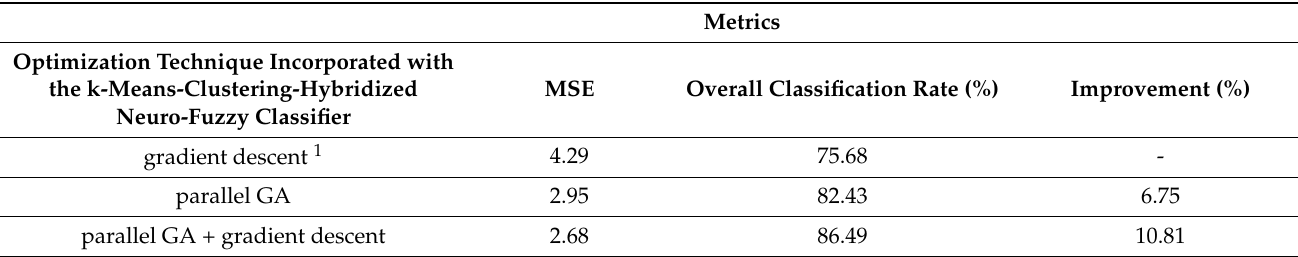
Table 4. Overall classification rates obtained in this experiment.